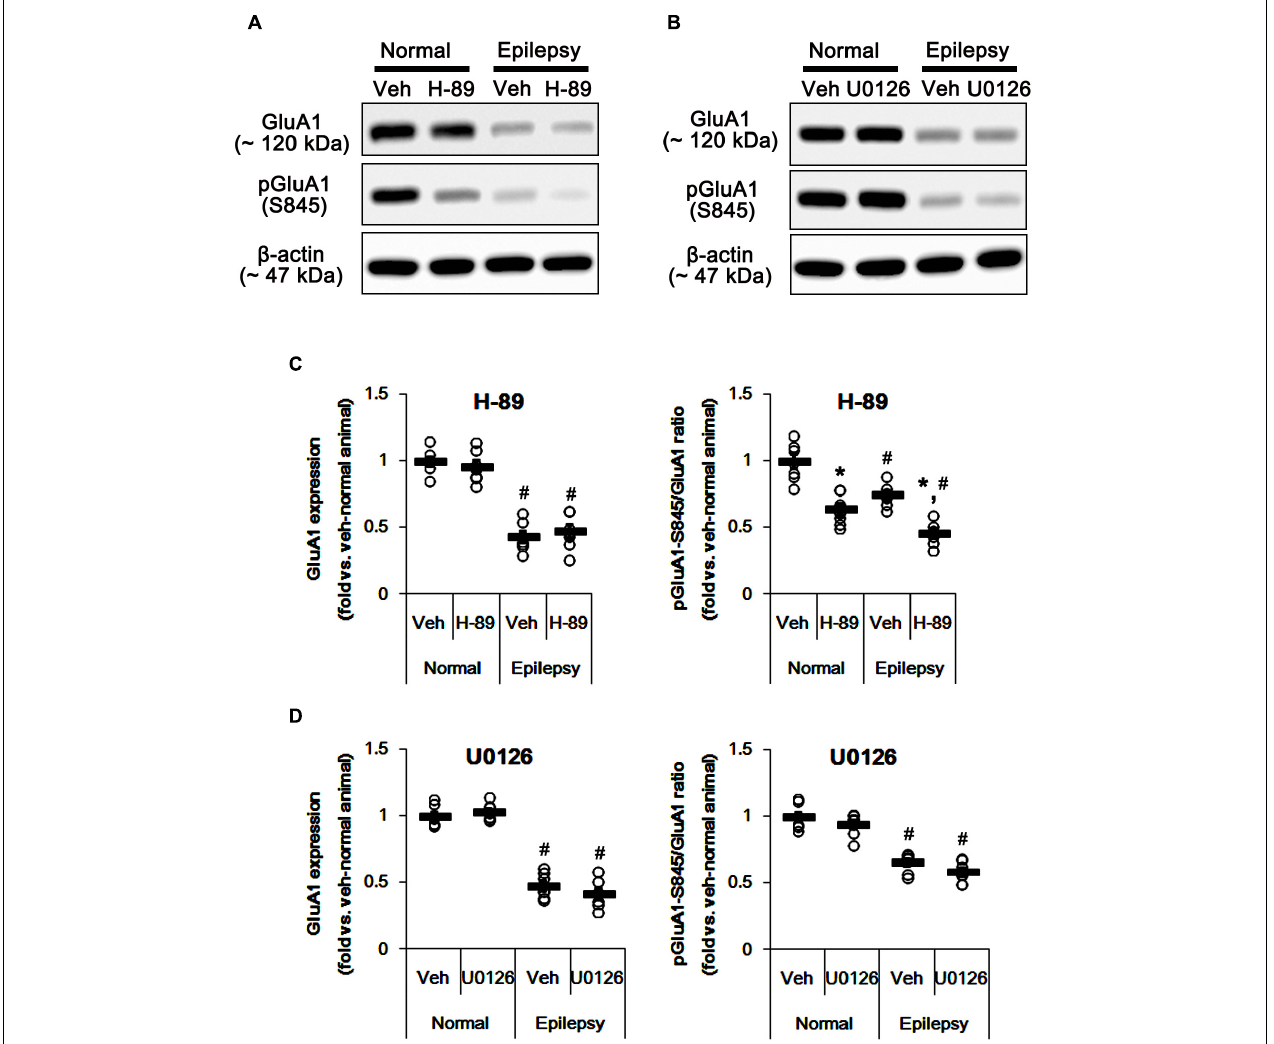
FIGURE 7 | Effects of H-89 and U0126 on GluA expressions and their phosphorylations. (A,B) Representative images for western blot of GluA1, phospho (p)-GluA1-S831, and pGluA1-S845 in the hippocampal tissues obtained from 3-days infused groups (B) . (C,D) Quantifications of GluA1, pGluA1-S831, and pGluA1-S845 levels in H-89- (C) and U0126-infused groups (D) . Open circles indicate each individual value. Horizontal bars indicate mean value. Error bars indicate SEM ( ∗ , # p < 0.05 vs. vehicle-treated animals and normal animals, respectively; n = 7, respectively).